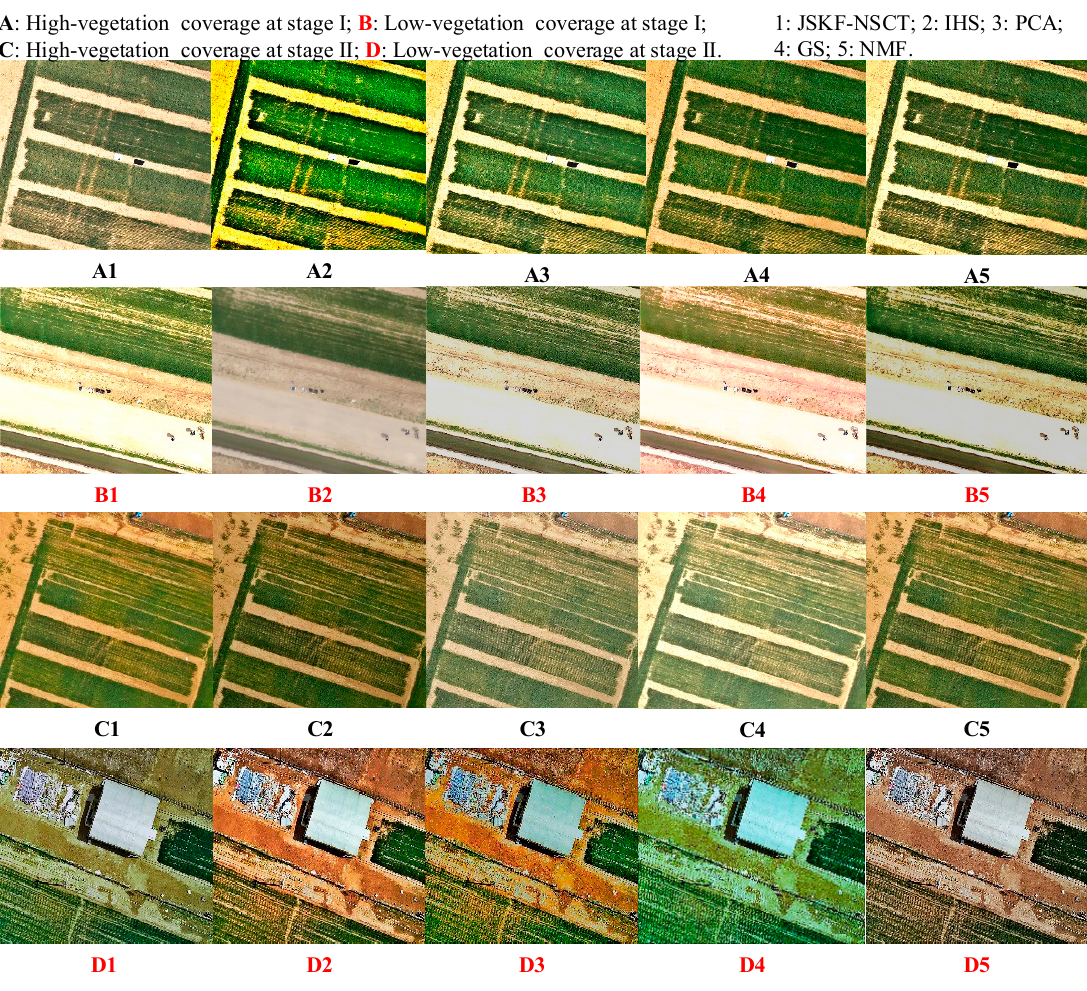
Figure 9. Comparison of fusion results using five different methods.